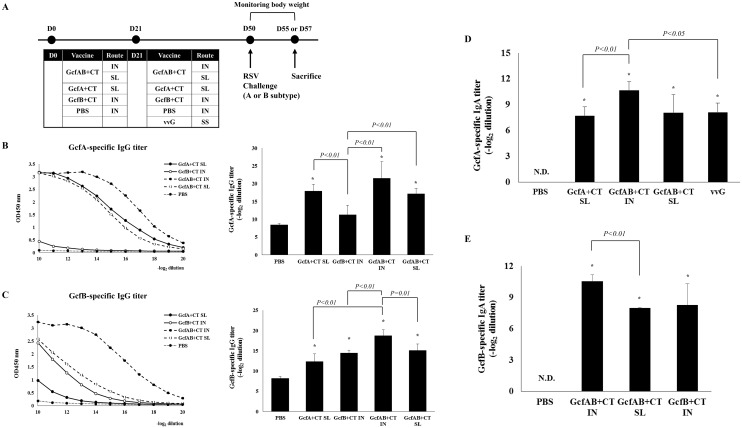
Characterization of humoral immune responses in GcfAB-immune mice.(A) The scheme used for animal experiments is shown in Fig 2. (B and C) Twenty-one days after the last immunization, RSV G-specific IgG titers in sera were measured by ELISA. GcfA (50 ng/well) or GcfB (100 ng/well) proteins were used as coating antigens, and goat anti-mouse IgG-HRP was used as a detection antibody. The cutoff optical density at 450 nm (OD 450 nm) was < 0.15 for a PBS negative result. (D and E) Five days after RSV A2 or B (KR/B/10-12) challenge, BAL fluid was harvested and the GcfA-specific or GcfB-specific mucosal IgA antibody responses were measured by ELISA. The results represent log2 endpoint values averaged from four mice. N.D., not detected. All data are expressed in mean ± SD (n = 4/group). Significant differences from the PBS control group are marked with asterisks (*). p < 0.01.